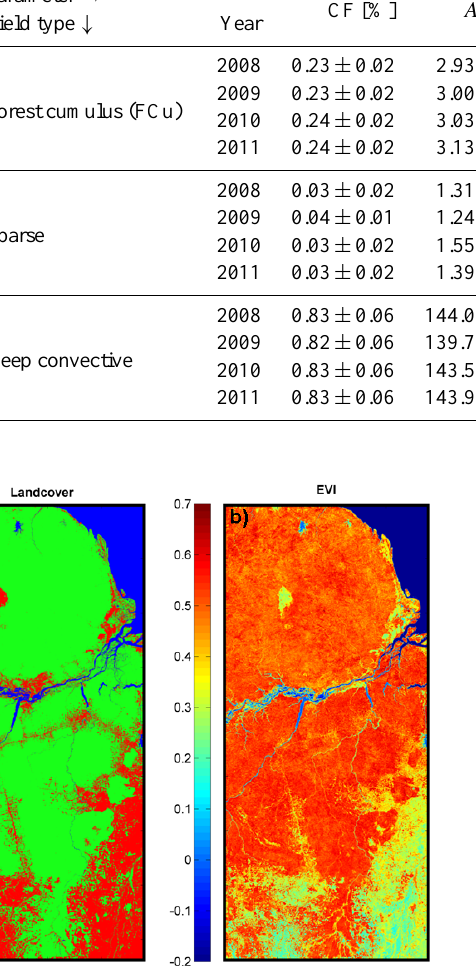
Figure 4. Land cover classification map (a) and mean J-A-S EVI (b) for the year